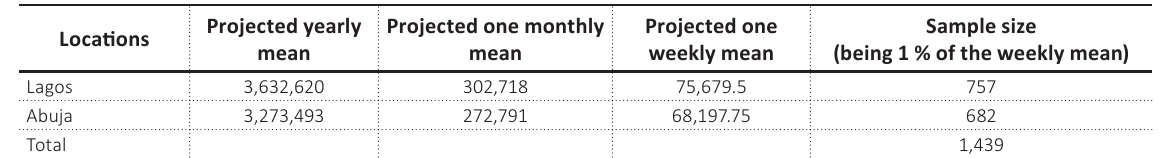
Table 1. Sample size derived for the